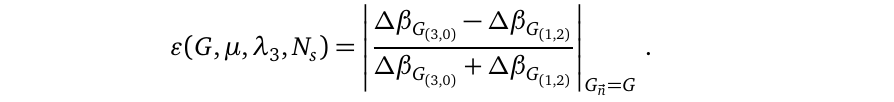
Figure 4: The regions in which (cid:34) < 1 dashed contour; lighter, dotted contour) colours for N (red) colour indicates ∆ β around a white line where (cid:34) = 0. The bilocal UV fixed point is indicated by a white dot. The area is almost N (cf.